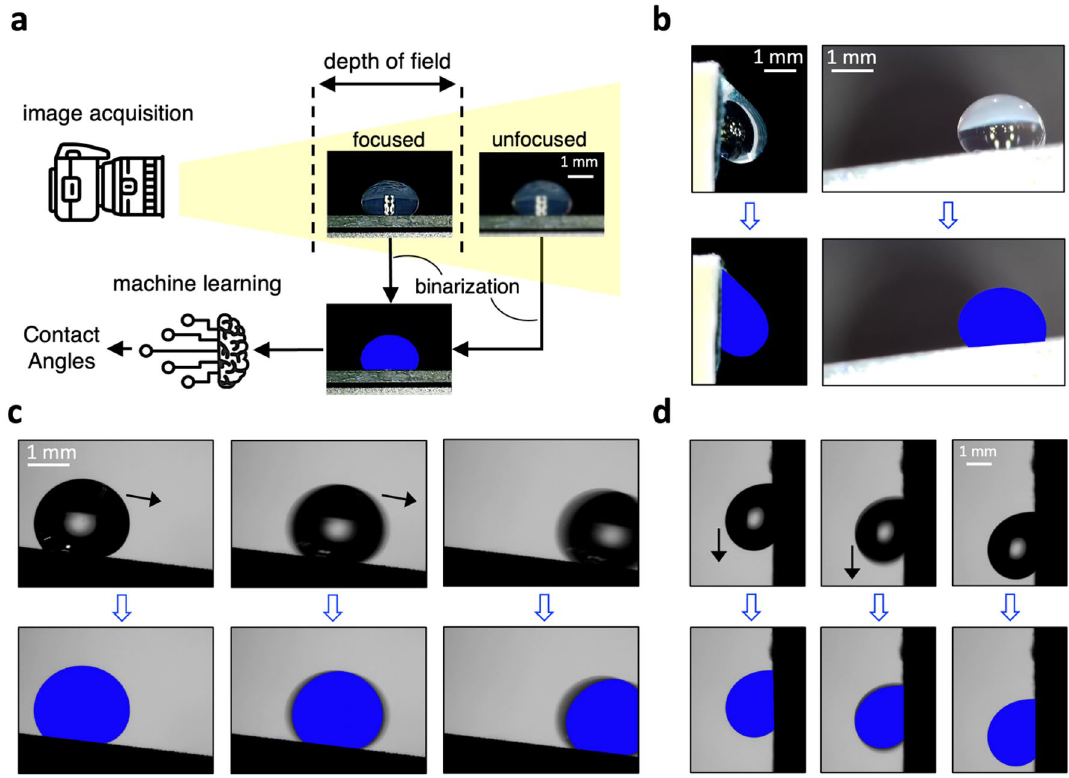
Figure 6. Extracting binarized masks from natural images to feed the CNN model. ( a ) Workflow that shows how the binarization algorithms obviate the need for camera auto-focusing. In the next step, the binarized maps are fed into the CNN model to create a ground truth dataset. Finally, the trained CNN model is leveraged to accurately estimate the left and right CAs of symmetrical or non-symmetrical drops based on the uniqueness and overall geometry of binarized maps. ( b ) Showcasing the ability of the binarization algorithms to extract and analyze the geometry of front-lit drops rolling down (left column) a vertical wall, and (right column) a sloped stage, ( c ) showcasing the ability of the binarization algorithm to extract and analyze the geometry of back-lit drops rolling down a sloped stage, or ( d ) a vertical wall. It should be noted that the accuracy of the proposed method is not sensitive to low SNR regions around the drop boundary triggered by capturing images via low frame-rate